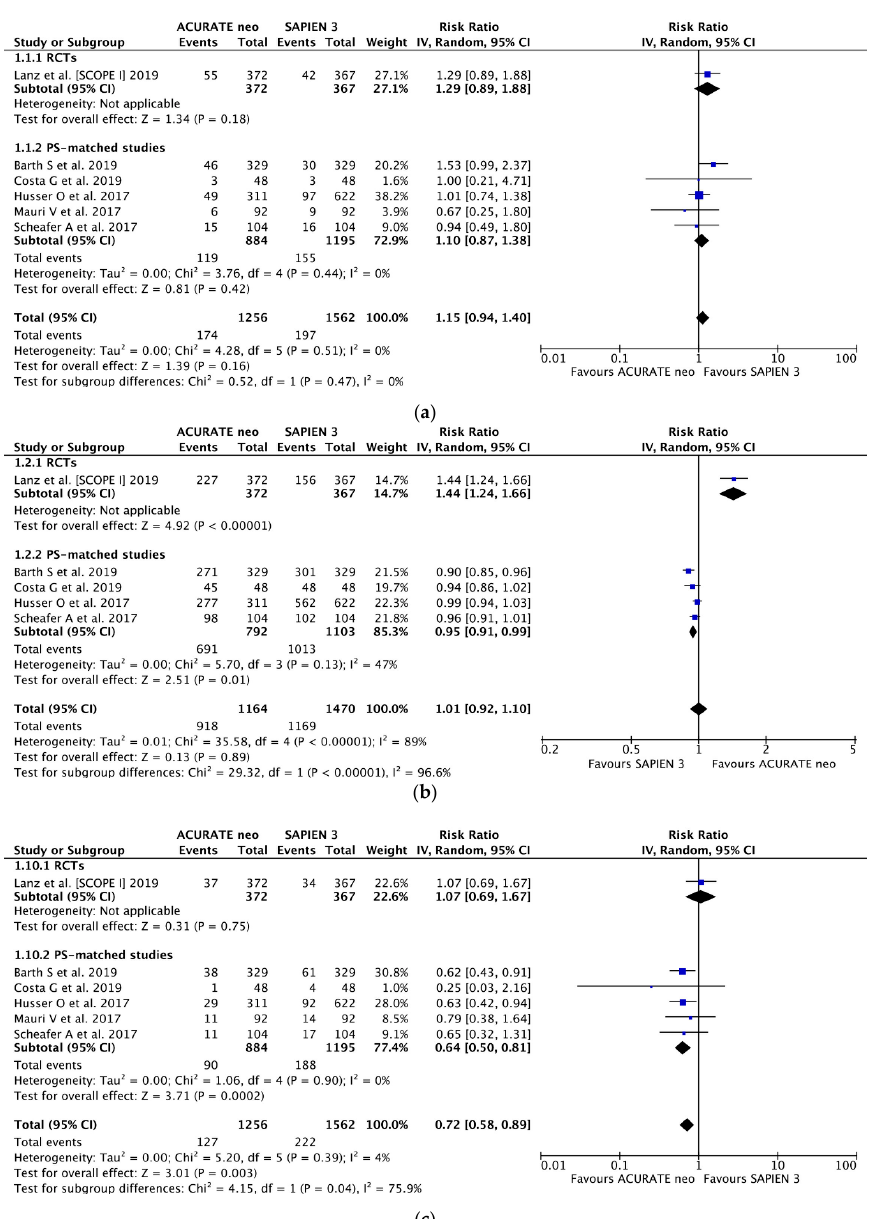
Figure 3. Individual and summary risk ratios with corresponding 95% confidence intervals for the comparison of ACURATE neo vs. SAPIEN 3 in the analysis of clinical outcomes: ( a ) early safety, ( b ) device success and ( c ) permanent pacemaker implantation.